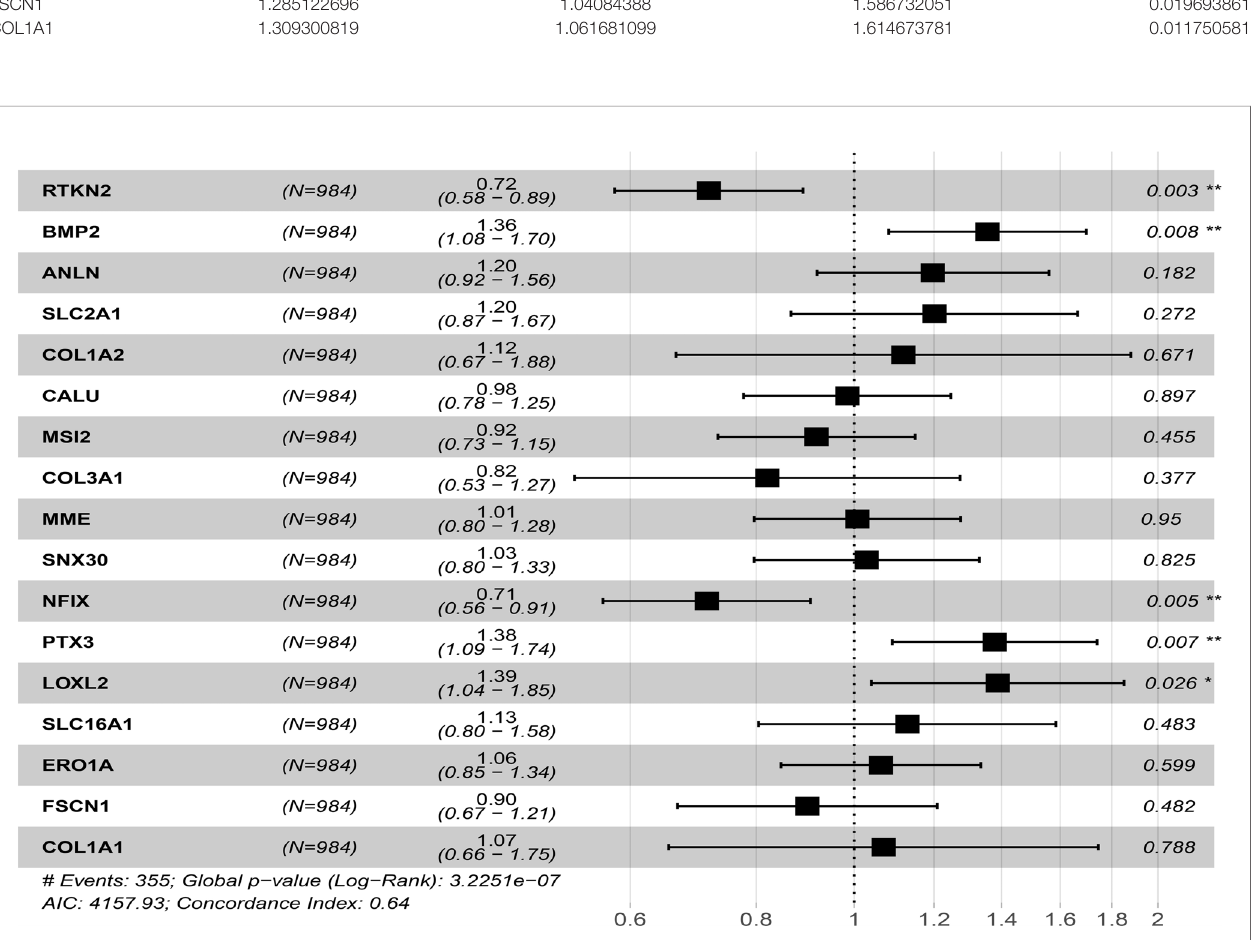
FIGURE 8 | Univariate and multivariate cox regression analysis showed that prognostic factors of NSCLC patients in ceRNA network. *P < 0.05; **P <